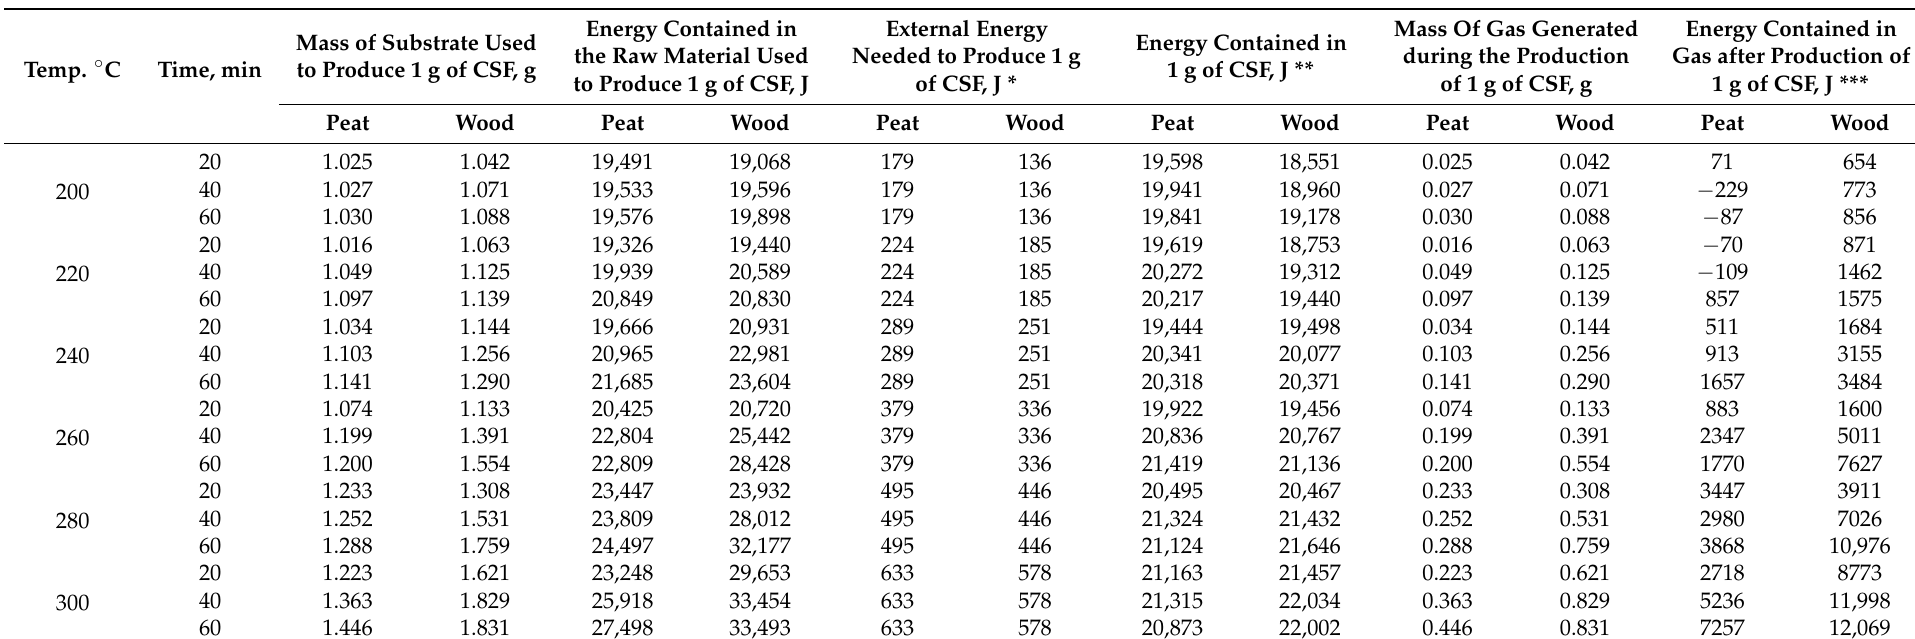
Table 4. Theoretical torrefaction mass and energy